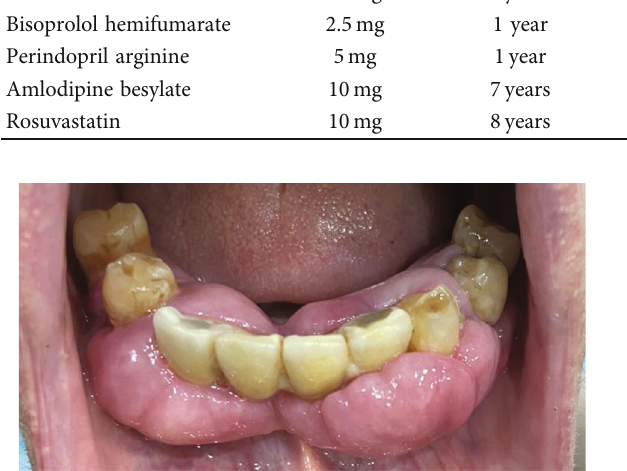
Figure 3: Panoramic radiograph presenting bone loss around teeth and lower 4-unit implant-retained